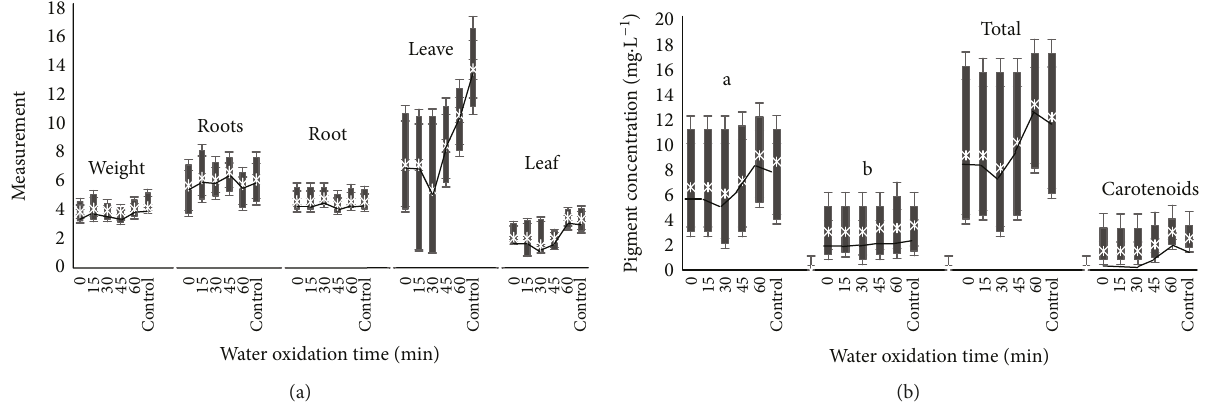
Figure 8: Willow tolerance (a) biomass parameters: weight (g), root number, root length (cm), leaf number, and leaf area (cm 2 ); (b) pigment concentration (mg · L − 1 ) at di ff erent oxidized water contact